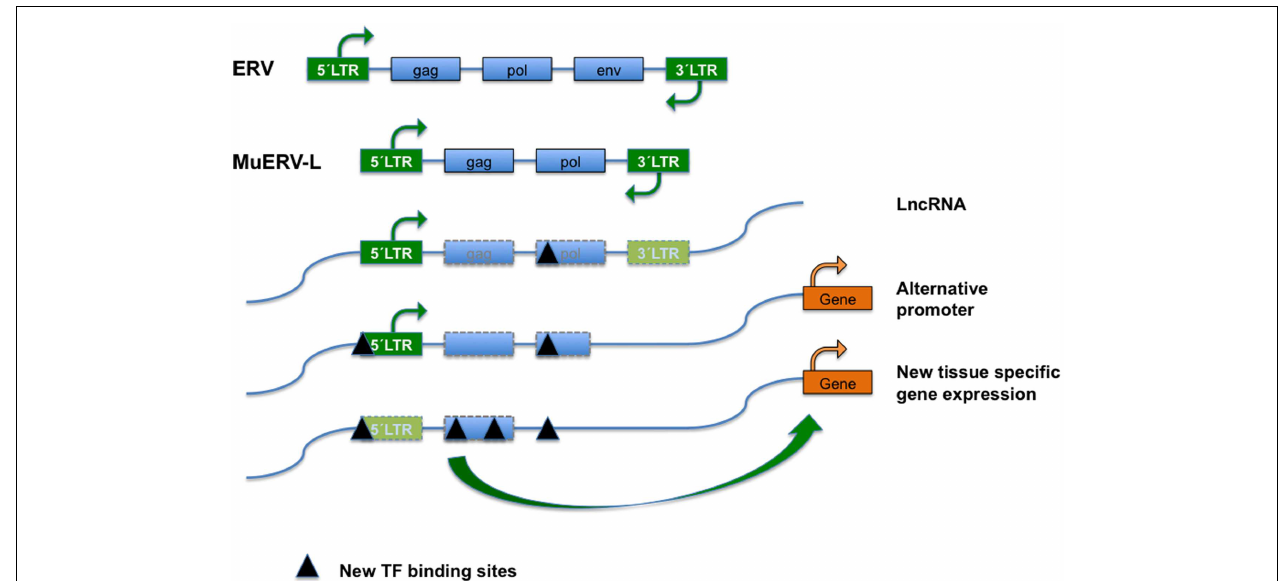
Pol genes but no detectable Env , a dUTPase gene (not shown). For the lack of ENV they are defective for cell to cell transmission. In addition to muERV-L, the mouse genome contains many thousands of ERV-L derived LTR elements termed MT2-Mm. LTRs are bound by transcription factors (TF) that drive transcription. ERV elements may also bindTF in the body of their genes, probably influencing chromatin dynamics or surveillance. After initial insertion (and transposition), ERVs over time may accumulate mutations and have contributed significantly to the generation of new transcription factor binding sites and hence impact on gene expression, genome function, and evolution.Transposon-derived promoters drive expression of alternative transcripts, including many of the LncRNAs detected by the ENCODE project, orchestrate stage, and tissue-dependent transcription, or serve as alternate